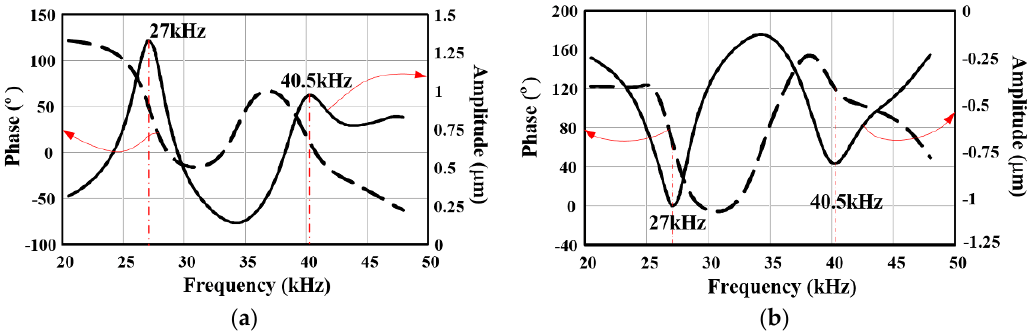
Figure 3. Frequency response plots of the V ‐ shape stator. Amplitude and phase of displacements of driving tip in the horizontal and vertical directions (applied voltage: 150 V): ( a ) horizontal component; and ( b ) vertical component.